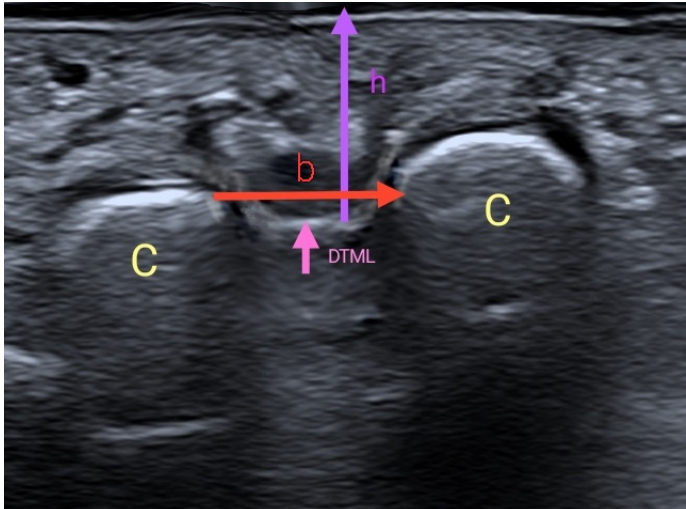
Figure 3. Ultrasound imaging of the measurements. C: Metatarsal heads 3 and 4 (M3 and M4). DTML: Deep transverse metatarsal ligament. h: Height: Distance between the DTML and the plantar skin in the middle area between M3 and M4. b: Base: Distance between M3 and M4.